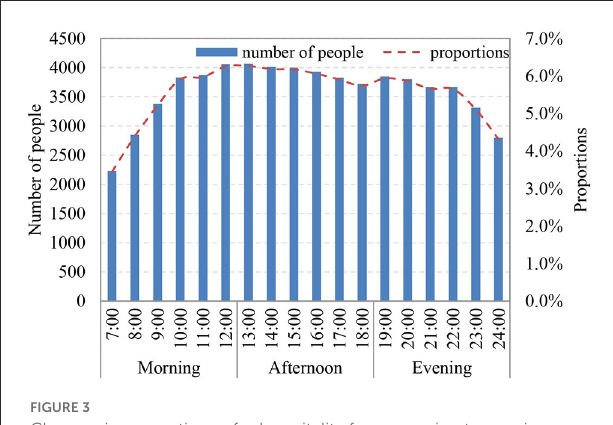
FIGURE3 Changes in proportions of urban vitality from morning to